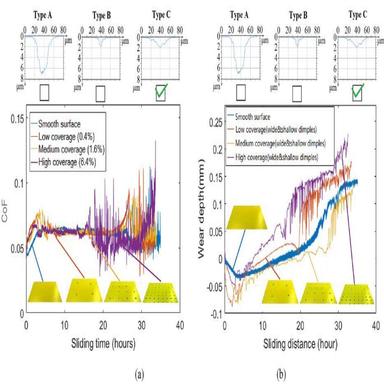
Measurement of (a) friction coefficient and (b) wear progression for different coverages of Type C (wide & shallow) dimples.